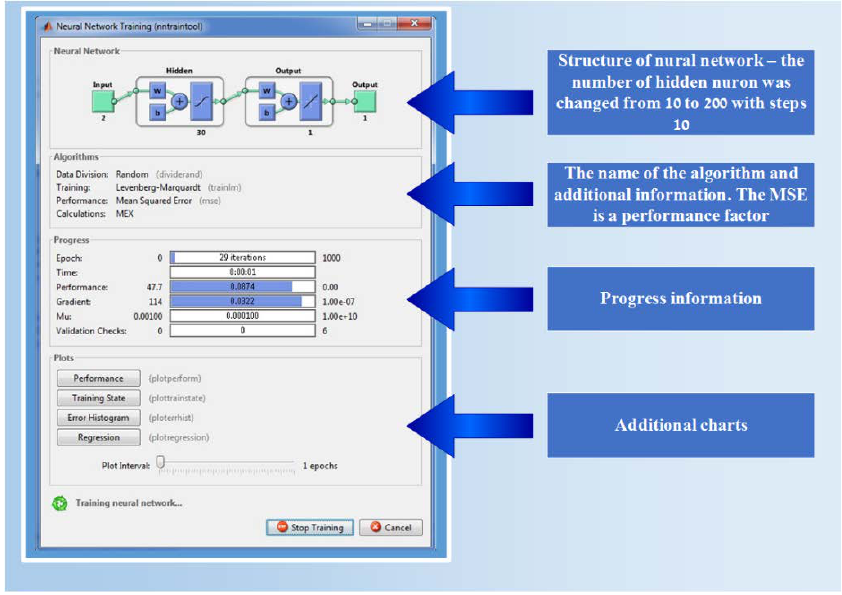
Figure 7. Dialog window of the Neural Network Training Matlab tool.